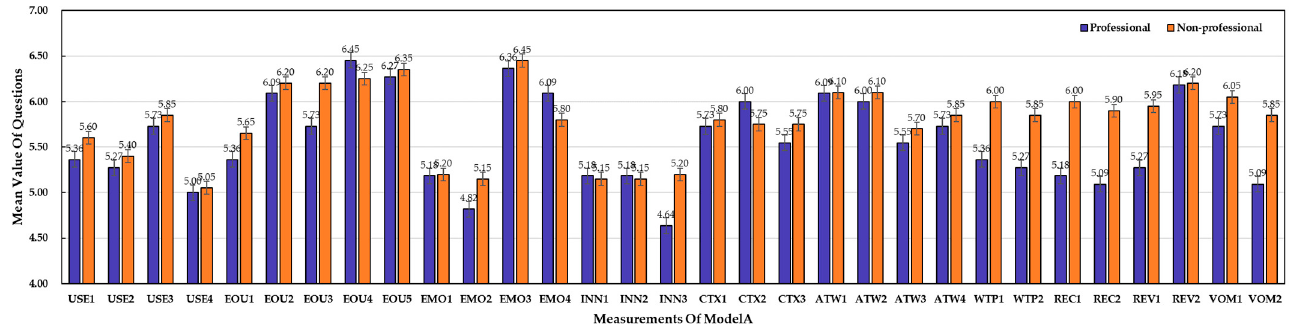
Figure 10. Comparison results of all measurements of Model B between professional and non-pro- fessional groups.